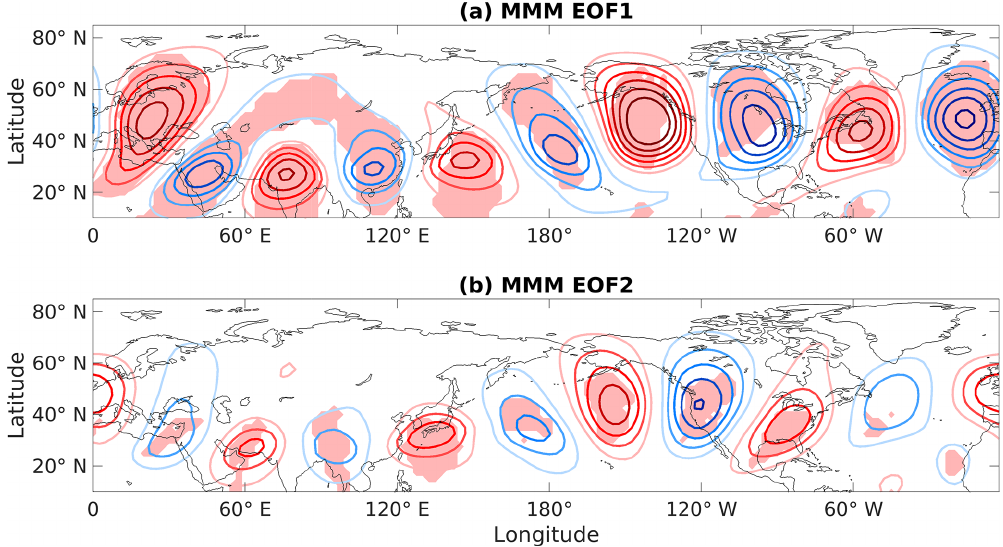
Figure 3. Multi-model mean EOFs for monthly mean seasonal anomalies of 300hPa DJF meridional wind, based on historical runs of 36 GCMs. The contour interval is 0.5ms − 1 and shading represents areas where > 90% of models agree with the sign of the observational